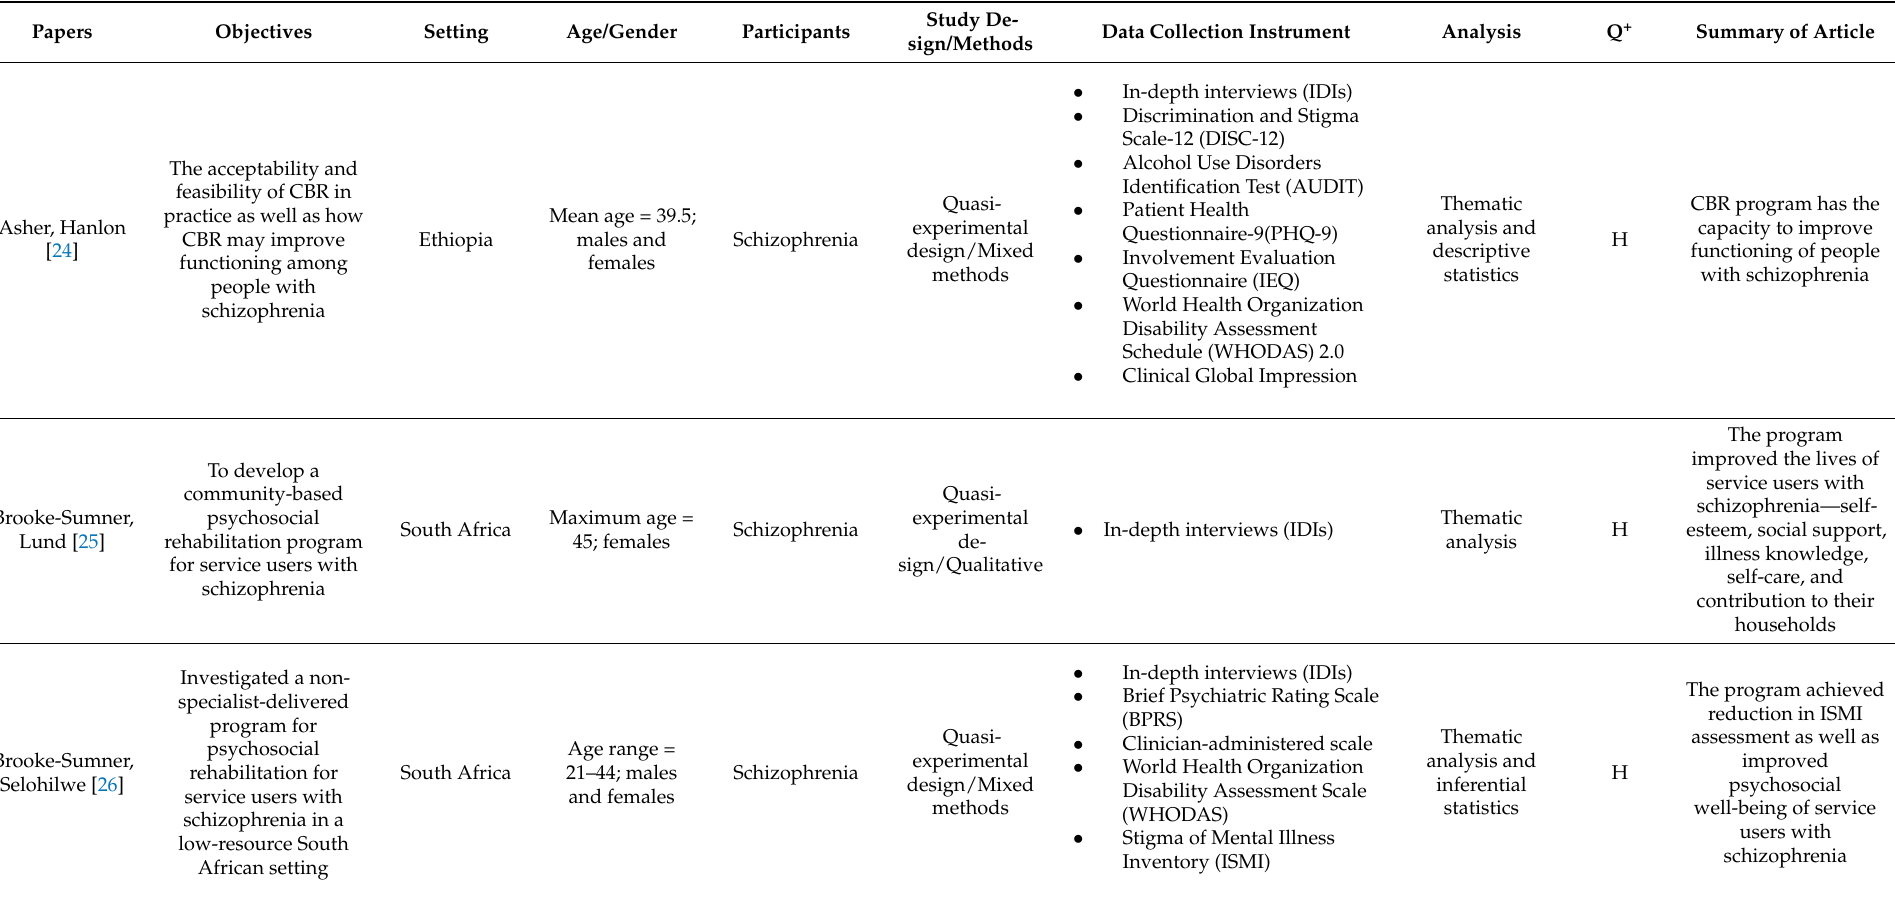
Table 2. Characteristics of included